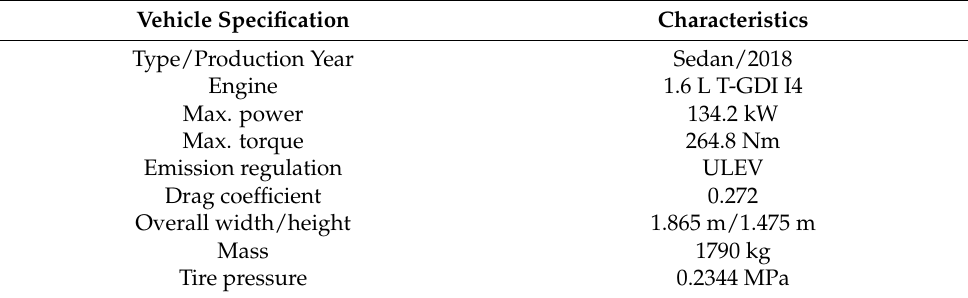
Table 1. Specifications of the test